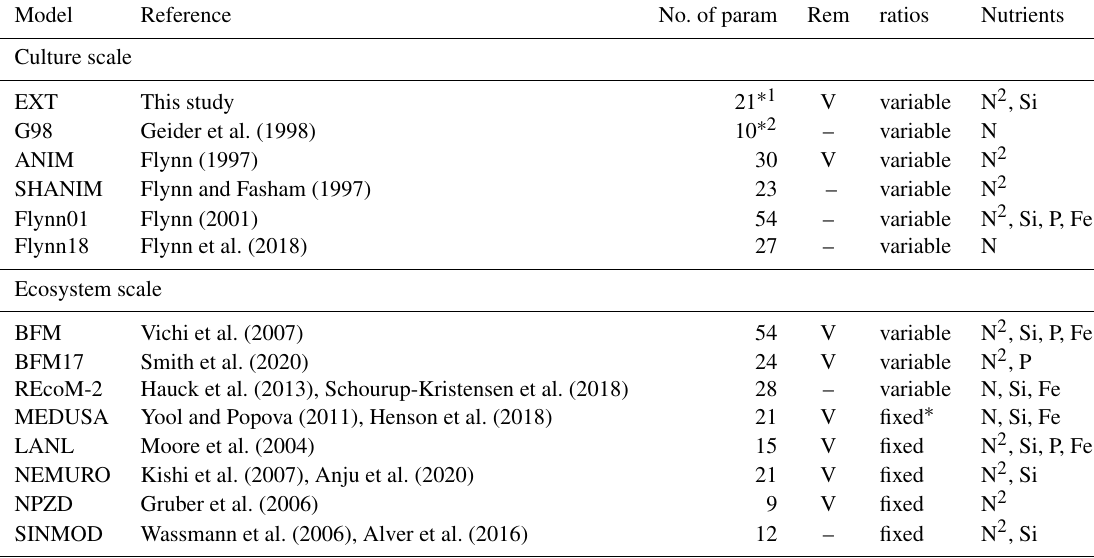
Table 1. A comparison of major components contributing to the complexity of different models discussed. “No. of param” is the number of parameters. In the case of ecosystem models (SINMOD, BFM, MEDUSA, LANL, NEMURO, NPZD) only the model formulations representing the components of the current model (phytoplankton growth, remineralization, nutrient dynamics) are considered. For the full ecosystem-scale models we give the original reference to the biogeochemical compartment of the ecosystem-scale models and examples for more recent versions with updated formulations of other model compartments (e.g., physical drivers). REM designates those models that include remineralization (Rem); marked with “V” is present and “–” is absent. Ratios shows if the stoichiometry in the model considers variable or fixed ratios of intracellular elements (C:N:Si:P:Fe). The nutrients considered are given under the nutrients column. If DIN is considered as both NH 4 and NO 3 , N is shown as N 2 . MEDUSA has Fe-dependent Si:N ratios, which makes them fixed in the Arctic (entry fixed ∗ in the